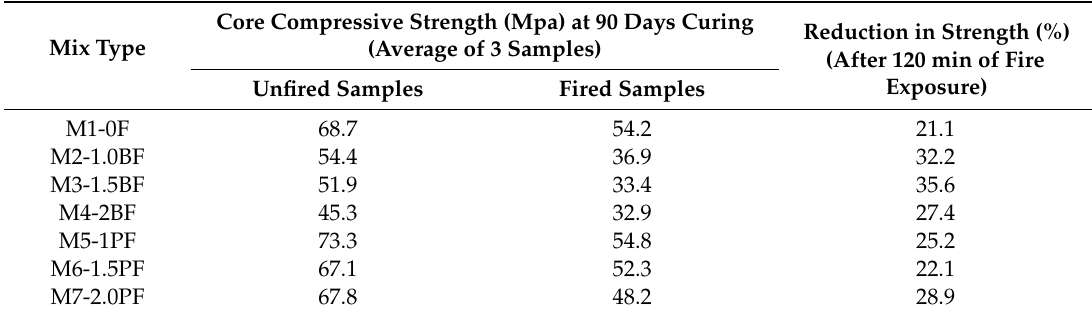
Table 3. Reduction in compressive strength after 120 min of fire exposure.